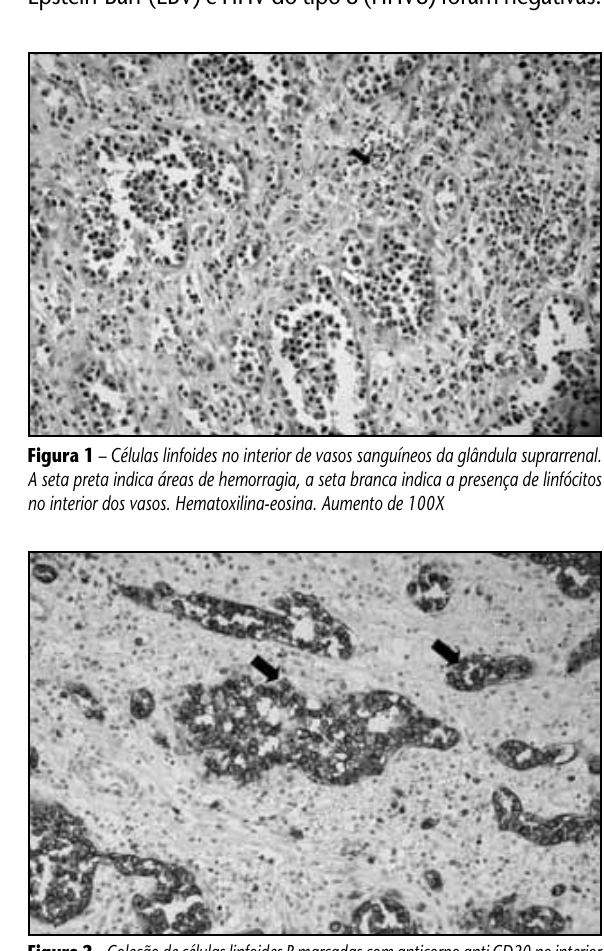
Figura 2 – Coleção de células linfoides B marcadas com anticorpo anti CD20 no interior de capilares da glândula suprarrenal. A seta indica alguns dos linfócitos aderidos ao endotélio. Aumento de